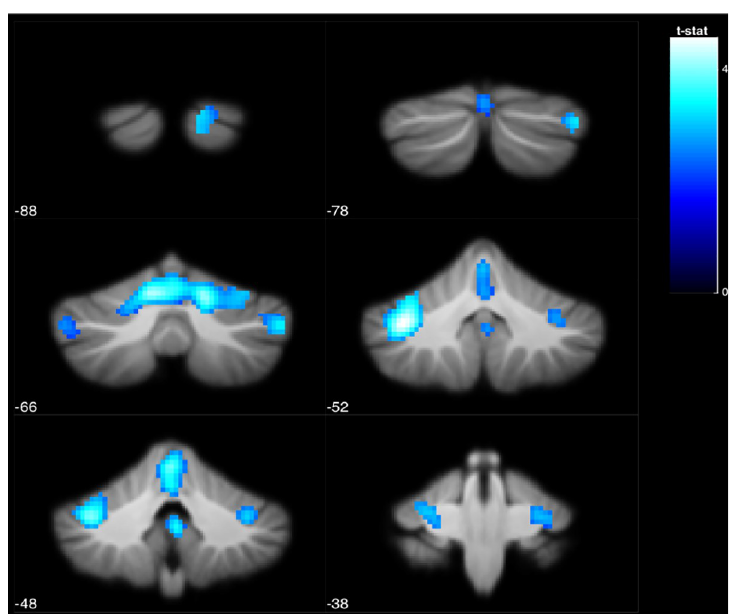
Fig 7. The brainstem and cerebellar lobule VI and Crus I exhibited a negative association between deactivation levels and balance performance in single leg stance (indicated by area of ellipse). The colored voxels show the regions of the brain in which the BOLD signal was significantly decreased from rest to stimulation in a way that was correlated with ellipse area across subjects. The shade of the color in each brain map corresponds to the t-value in the legend bar.